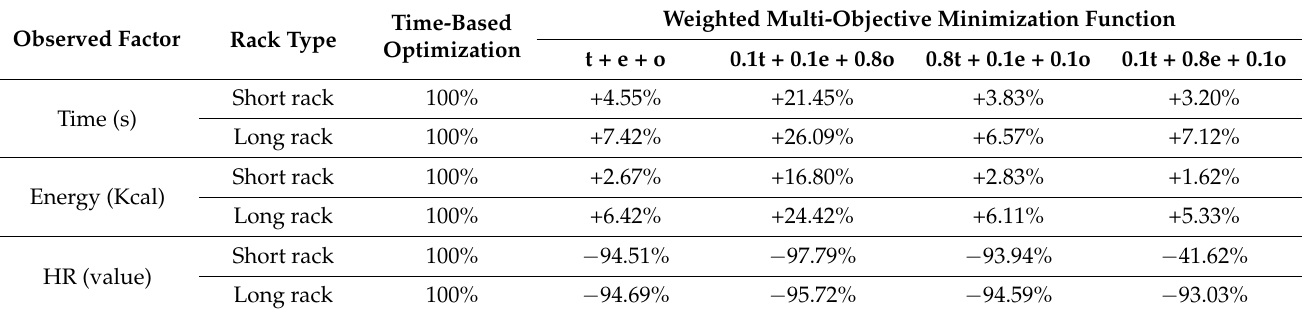
Table 9. Comparisons of the average results from a perspective of time-based objective minimization function. Observed